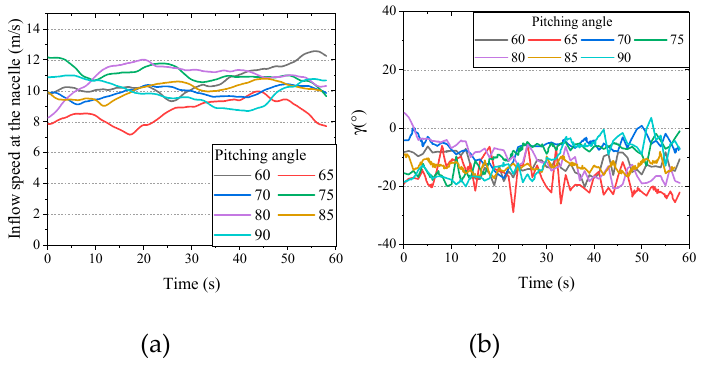
Figure 13. Inflow speed ( a ) and yaw angle ( b ) at the nacelle in the testing cases.